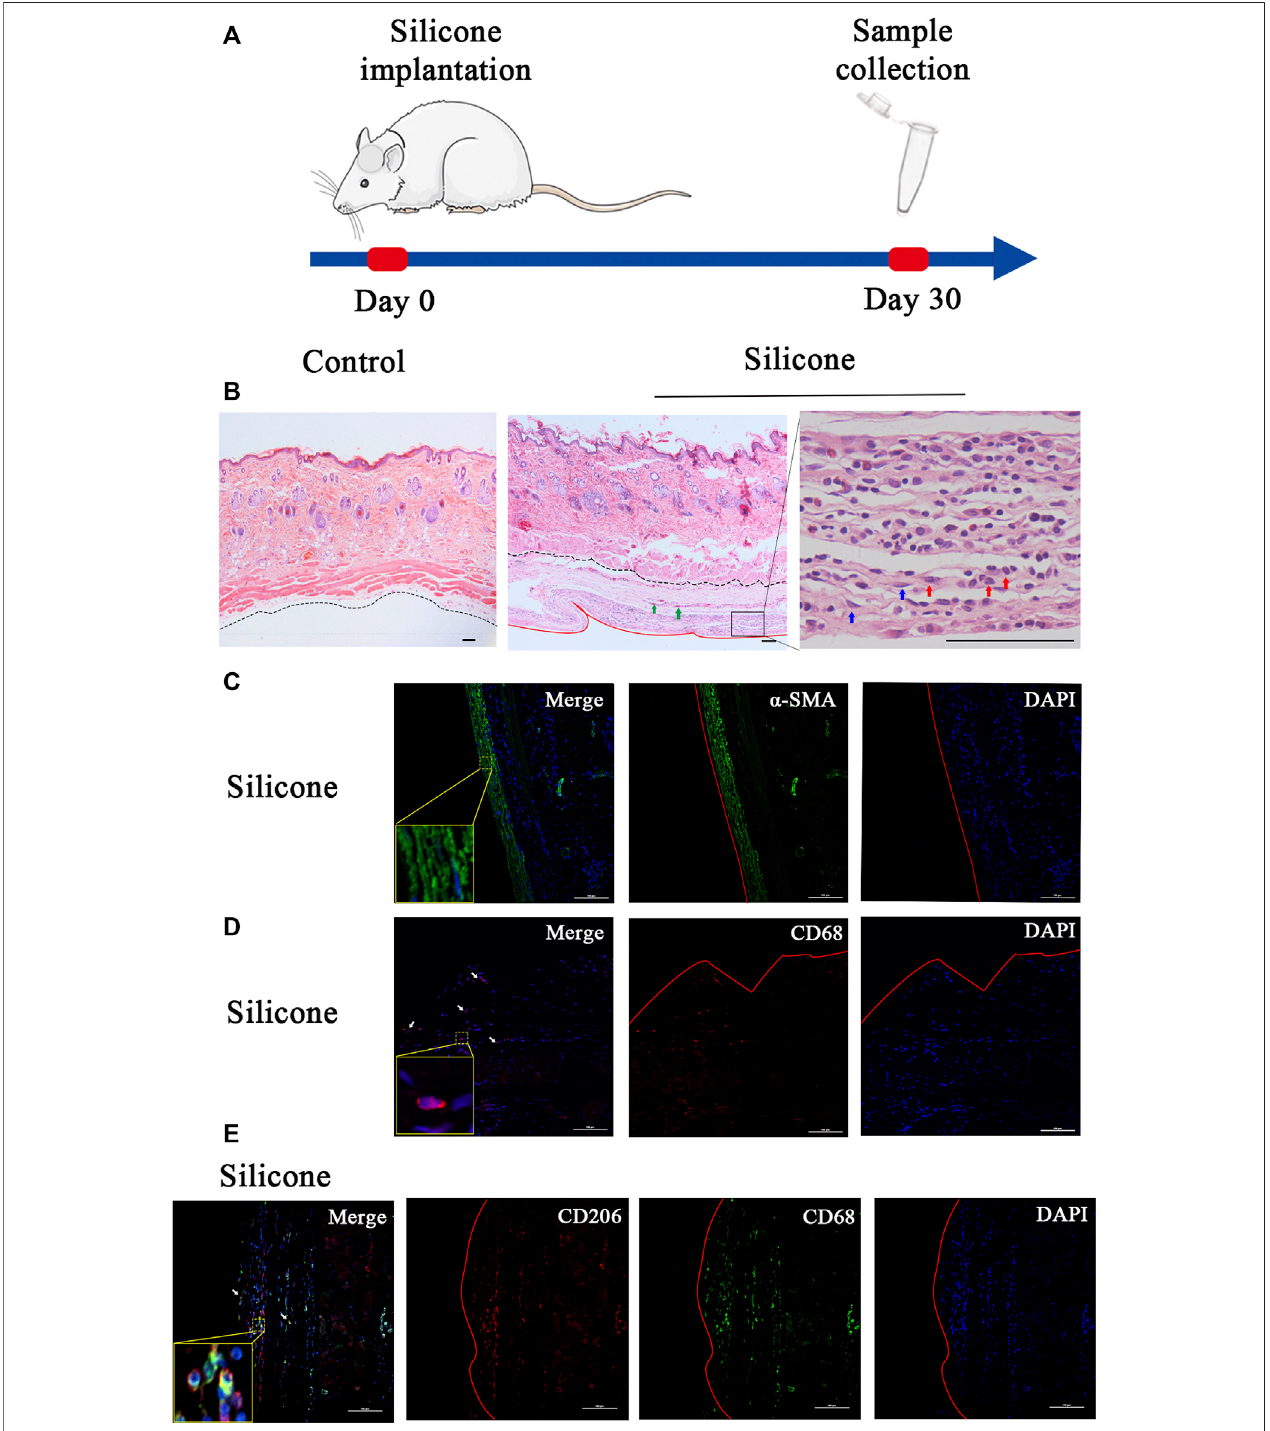
FIGURE 1 | Overview of the study design and histological characteristics of fi brous capsule. (A) Schematic presentation of procedural timeline of silicone implantation. (B) H&E staining showed a fi brous capsule wrapped around the silicone implant. The fi brous capsule was located beneath the muscle layer. No capsule formed under the control skin. The black dotted line marks the boundary between the skin and fi brous capsule, the red solid line marks the interface between fi brous capsule and silicone implant. Green arrows point to blood vessels, blue arrows point to myo fi broblasts, red arrows point to macrophages. (C) The immuno fl uorescence staining of α -SMA in capsule showed myo fi broblast differentiation in silicone – implanted group. (D) The immuno fl uorescence staining of CD68 in capsule showed macrophage recruitment in silicone – implanted group. Arrows point to macrophages. (E) The immuno fl uorescence staining of CD68 and CD206 in capsule showed M2 macrophages. α -SMA: alpha-smooth muscle actin. Insets show high-magni fi cation images. Scale bar = 100 μ m. The red solid line marks the interface between fi brous capsule and silicone implant.